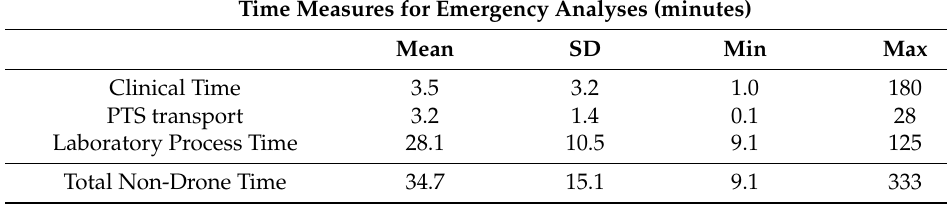
Table 3. The time elements in the transport